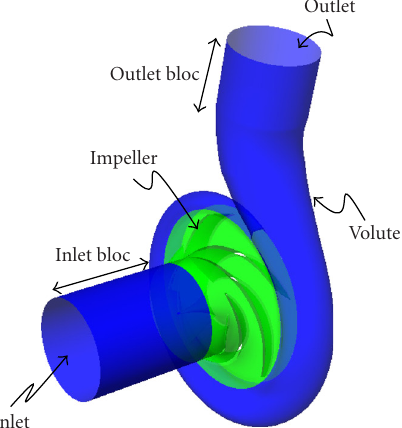
Figure 9: 3D elements of the pump NS32.